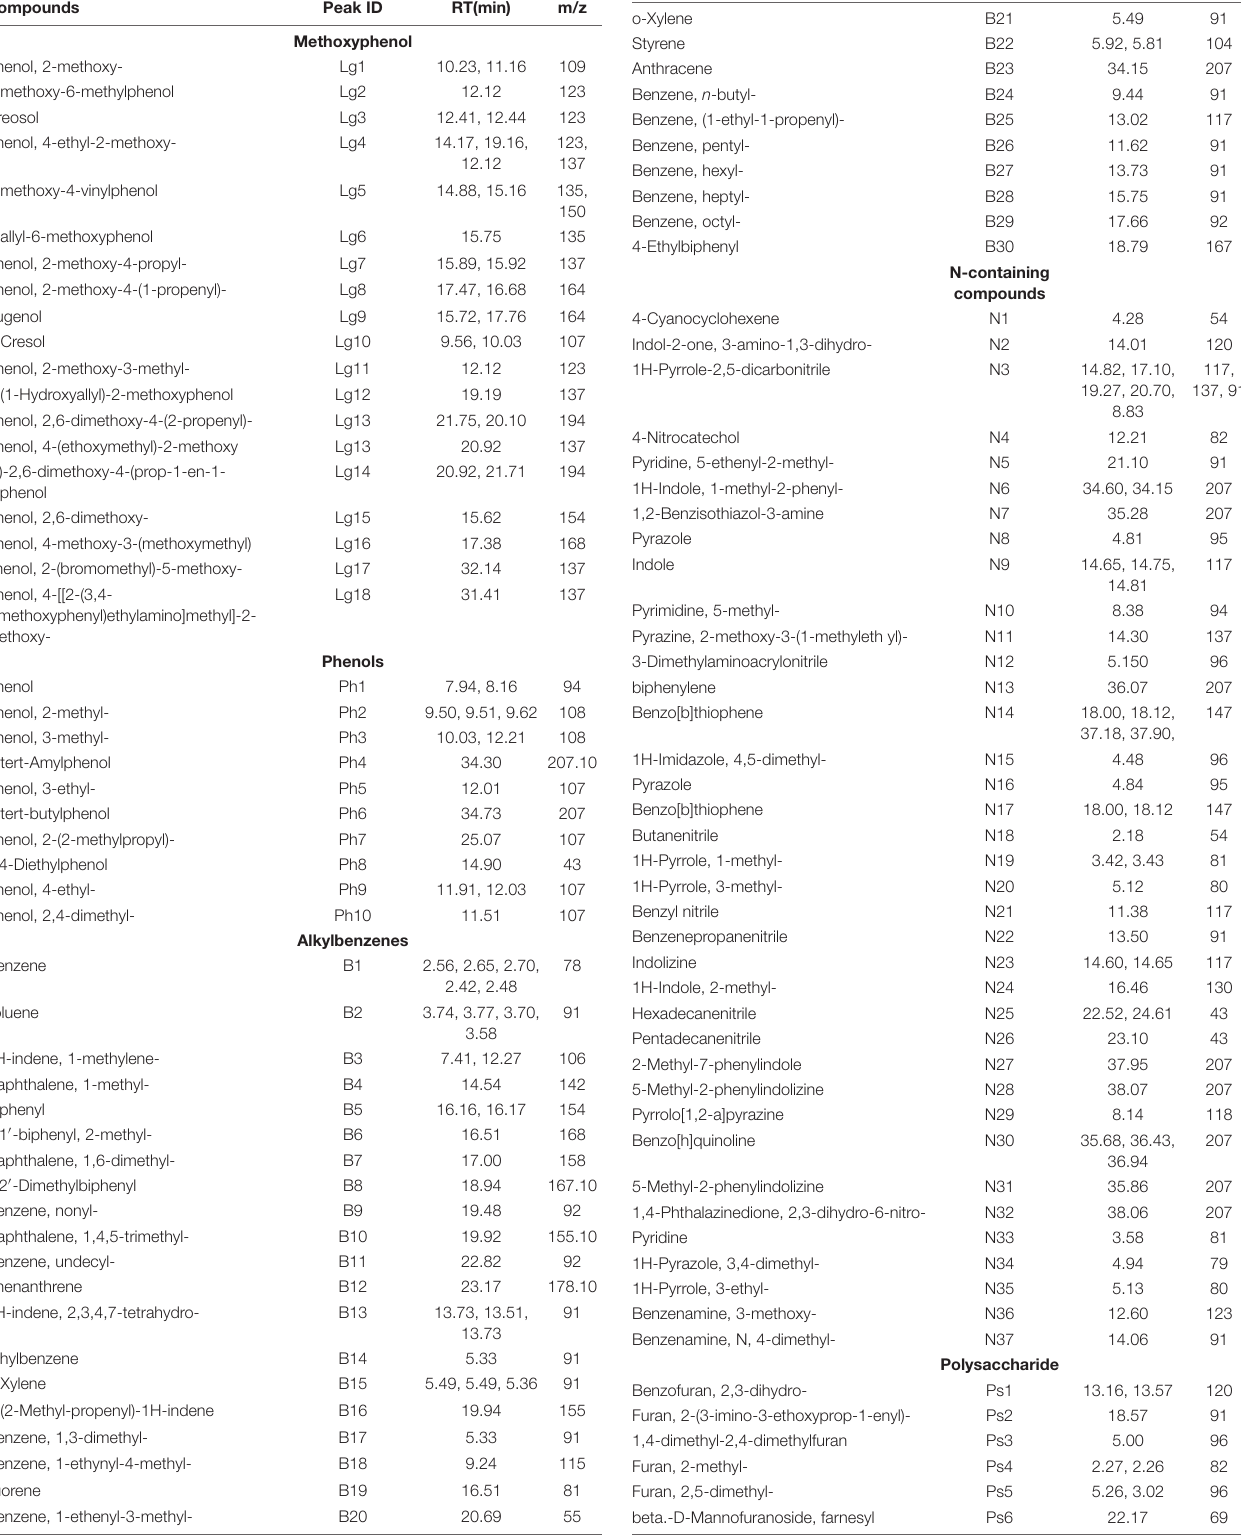
TABLE 1 | List of pyrolysates released from samples in ectopic fermentation systems (EFS). Compounds Peak ID RT(min) m/z